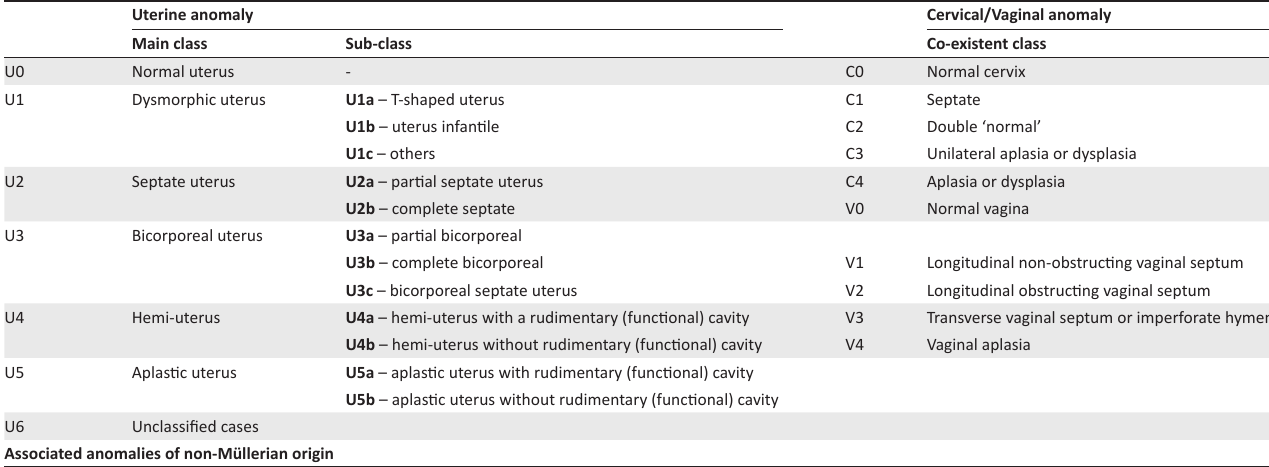
obstructive cervical or vaginal malformations with a normal uterus, which constitutes about 22 out of the 39 types of anomalies. 13 The ASRM classification does not provide specific classes for these anomalies and groups them all under Class